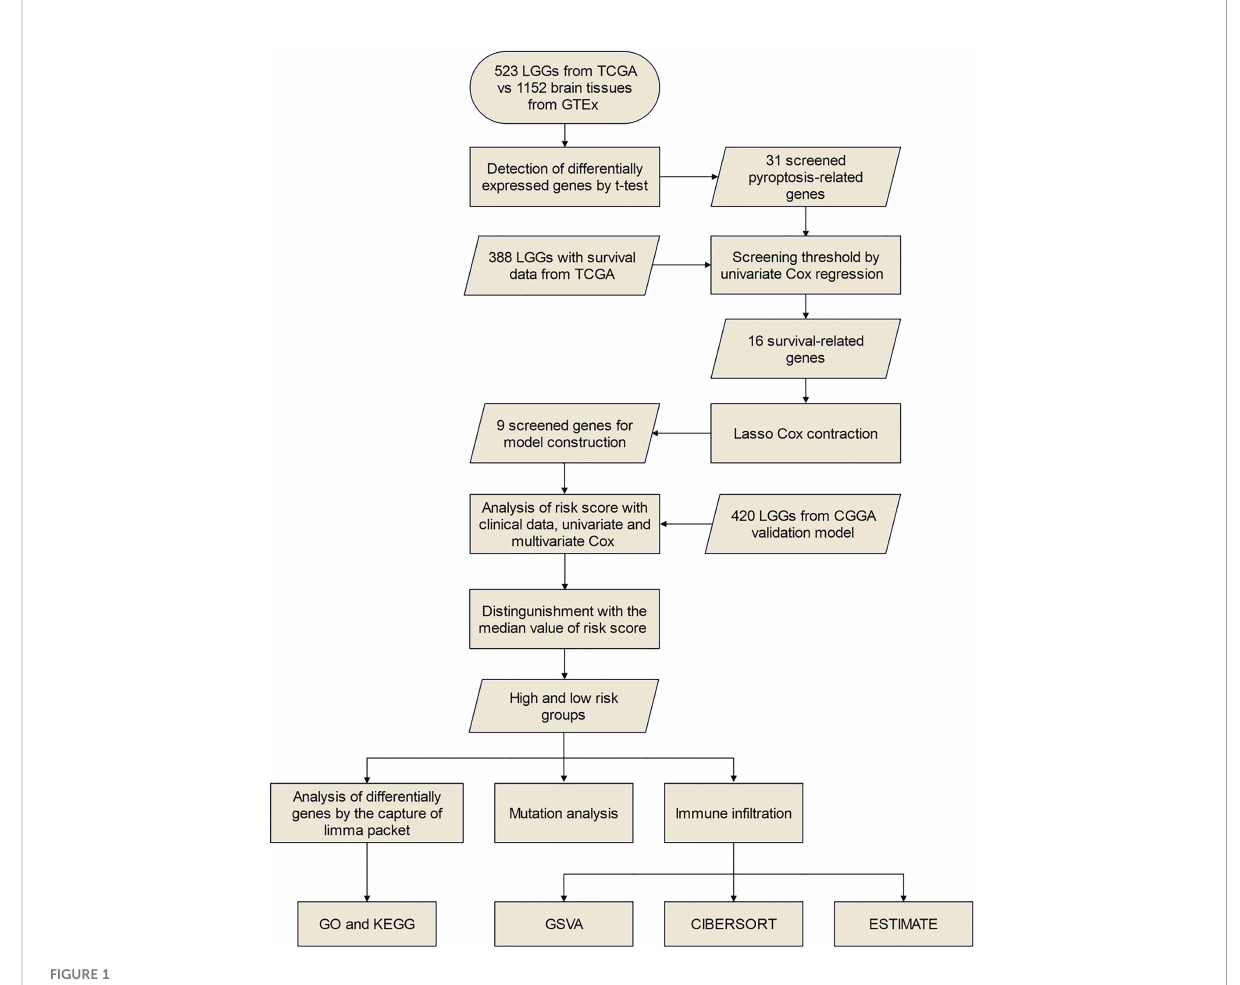
FIGURE 1 Speci fi c work fl ow diagram of data